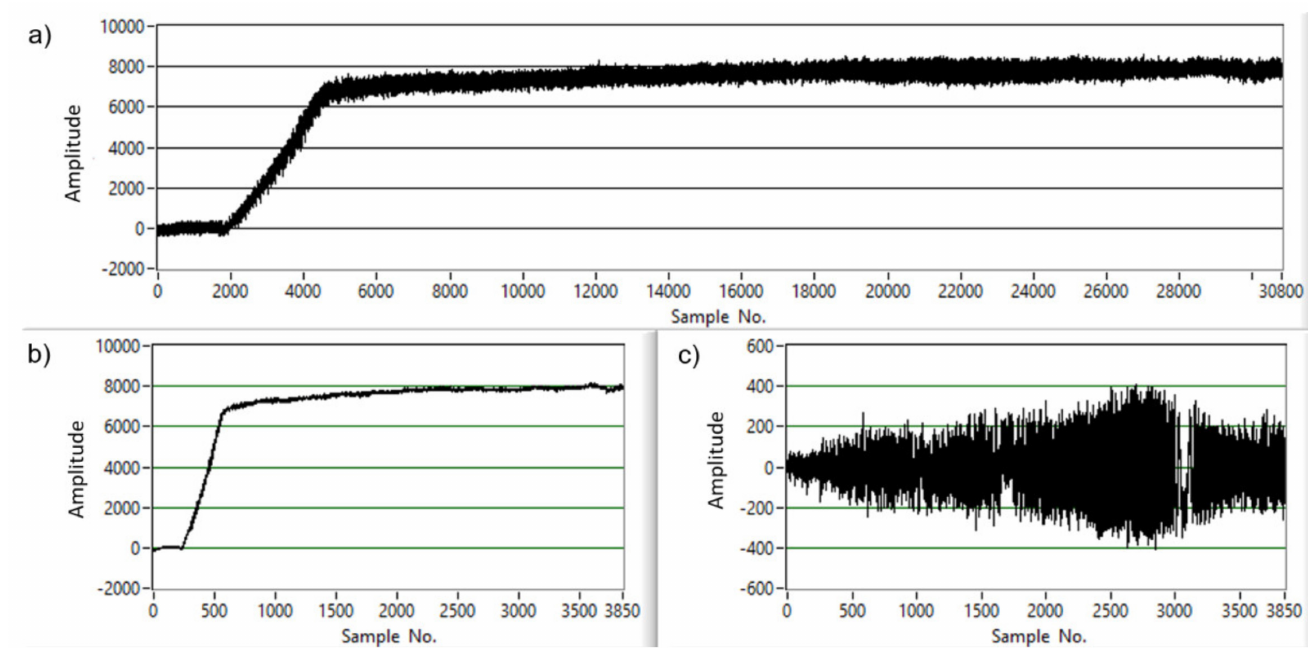
Figure 6. The waveforms of the force signal F z (Experiment 3). ( a ) original signal ( b ), the band signals obtained from the WPT—package AAA ( c ) the band signals obtained from the WPT—package